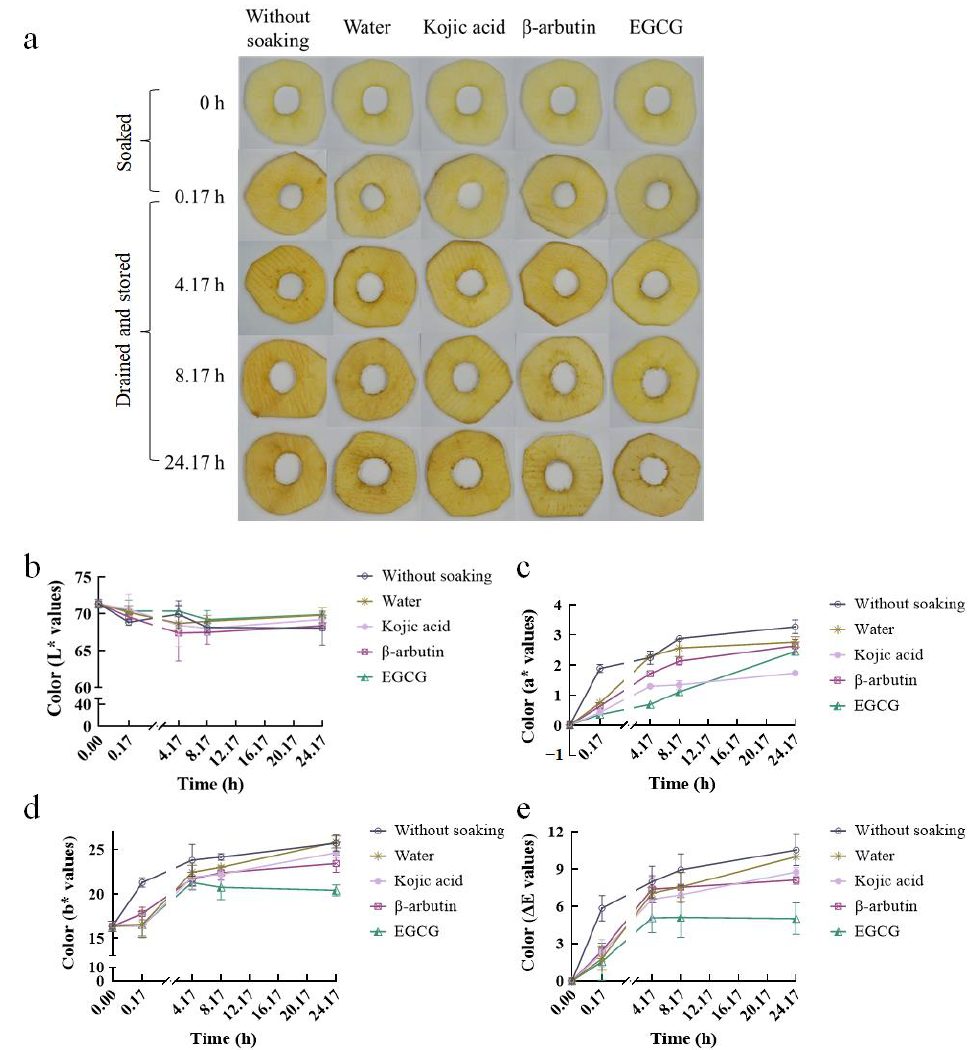
Figure 2. Effect of sample soaking on chromatic aberration of apple slices. Fresh apple slices of the same thickness were soaked in 1 mM of kojic acid, β -arbutin and EGCG solution for 10 min, and the change of color ( a ), L* ( b ), a* ( c ), b* ( d ) and ΔE ( e ) was observed and detected at the set times. Apple slices soaked by water were used as negative control, while apple slices without soaking were used as blank control.